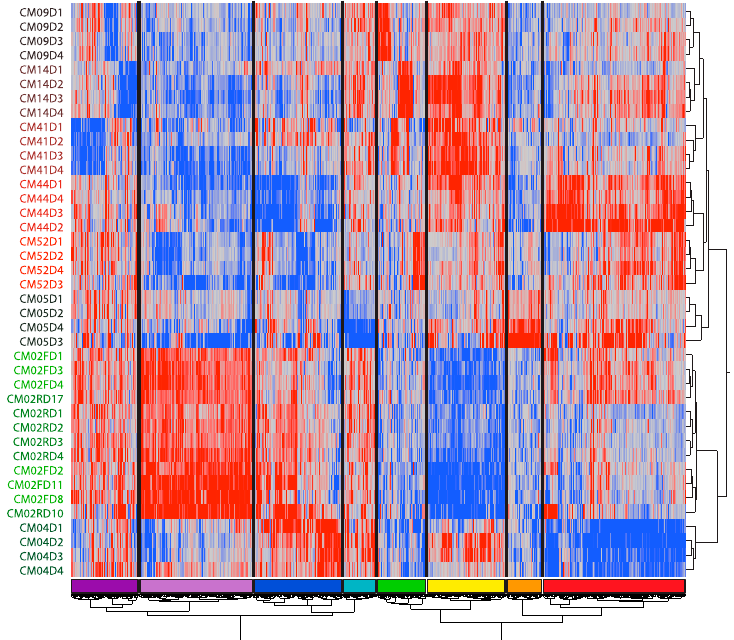
Figure 4. Two-way hierarchical clustering of differentially expressed gene (DEG) by individual and time. Each row represents one patient on the day indicated by the last number of the label, and each column is the standardized expression of a DEG in ANOVA contrasting each individual with the remaining sample. The figure highlights clusters of genes that tend to be patient-specific, but shows (like the BTM analysis) that these are to some extent shared by pairs of patients. The colored bar at base indicates clusters discussed in the text.